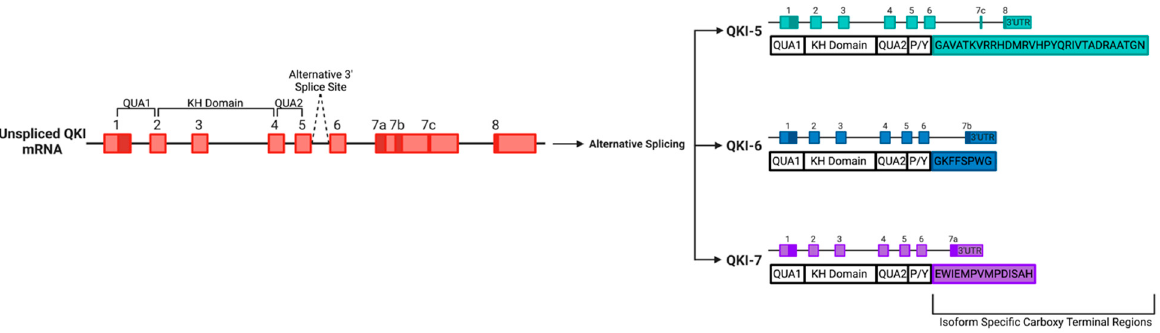
Figure 2. The Quaking (QKI) locus expresses alternatively spliced RNA-binding proteins belonging to the signal transduction and activation of RNA (STAR family).A schematic displaying the three major isoforms of QKI, namely, QKI-5, QKI-6 and QKI-7, yielded from the alternative splicing of the QKI gene, displayed with both exons and introns.